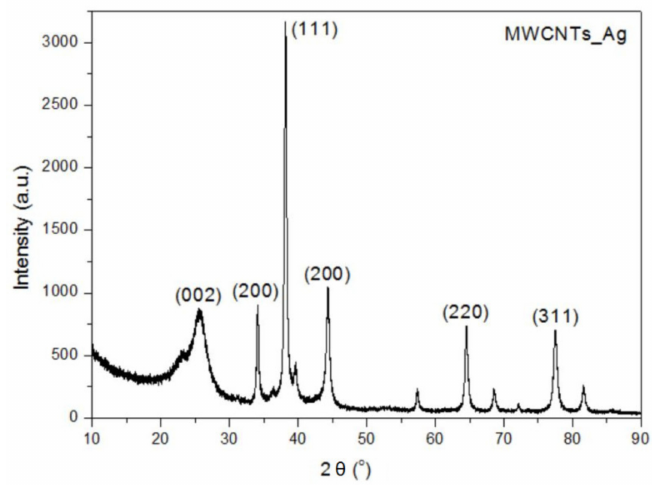
Figure 5. XRD of MWCNTs_Ag. Table 2. Summary of the XRD characterization of MWCNTs and decorated